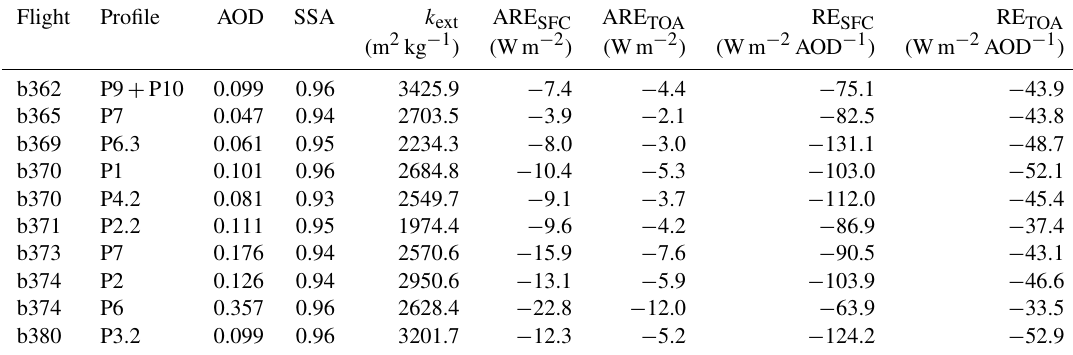
Table 3. “Ambient” aerosol optical depth at 550nm (AOD), “dry” single-scattering albedo at 550nm (SSA), dry specific aerosol extinction at 550nm ( k ext ), and diurnally averaged values of the aerosol radiative effect (ARE) and radiative efficiency (RE) at the surface (SFC) and top of the atmosphere (TOA) across Europe during EUCAARI-LONGREX. Flight